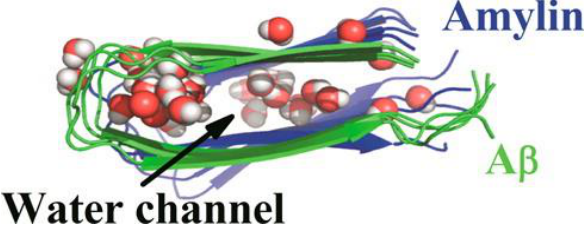
Figure 20. Location of the water channel present in the hetero-oligomer of A β 15–40 and hIAPP 10–35 . Adapted from Berhanu and Hansmann [106]. Copyright 2015 American Chemical Society.